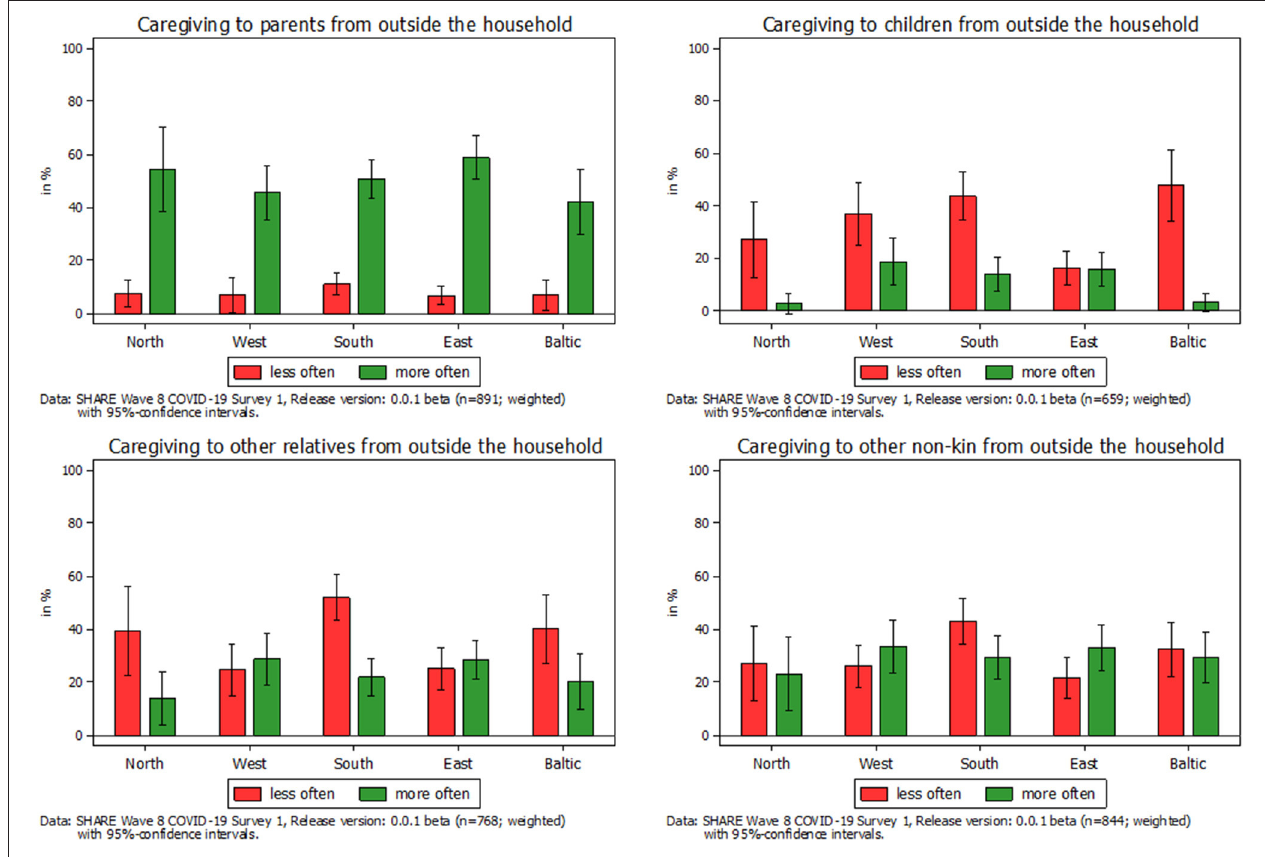
FIGURE 2 | Change in frequency of caregiving to someone outside their own household by type of care relation.